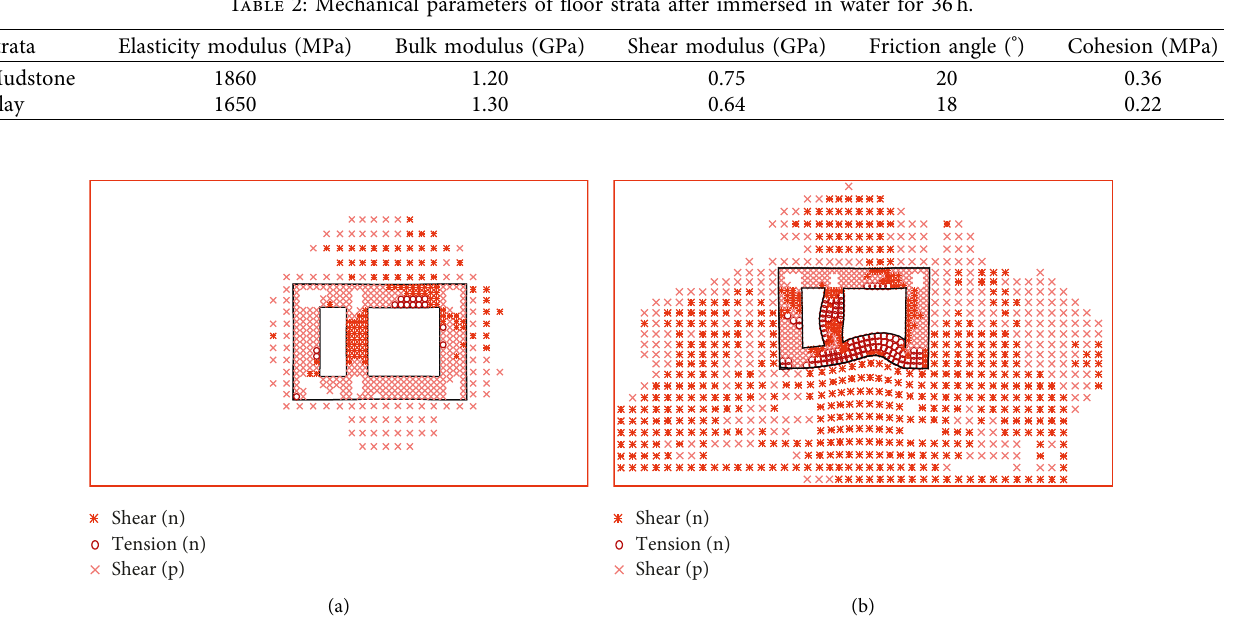
Figure 9: Comparison of plastic zone distribution under conditions (a) without water and (b) with